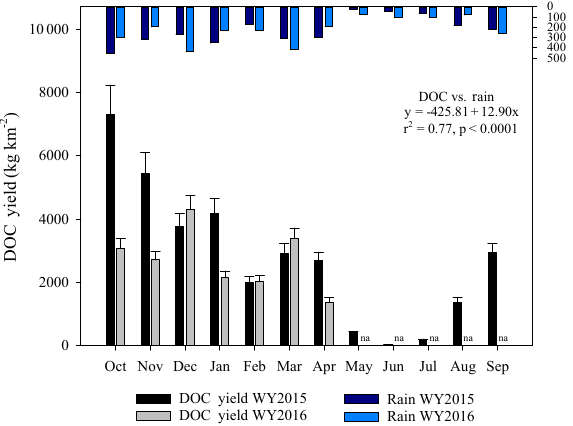
Figure 4. Monthly areal DOC yields and precipitation for water year 2015 (WY2015) and the wet period (1 October–30 April) of water year 2016 (WY2016). Error bars represent standard er- ror. Total rain and DOC yield were significantly correlated ( r 2 = 0 . 77), and months of higher rain produced higher DOC yields. In WY2015, the majority of DOC export ( ∼ 94% of annual flux) oc- curred during the wet period ( ∼ 88% of annual precipitation).